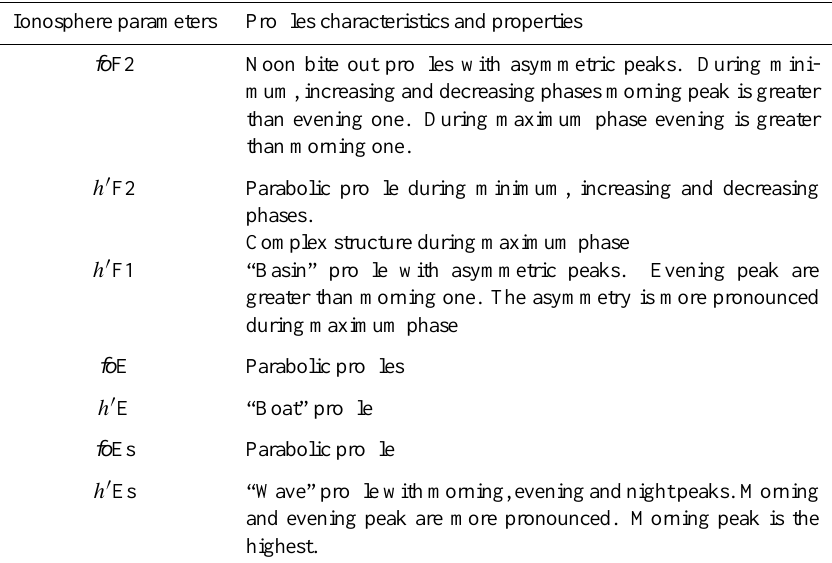
Table 2. Ionosphere diurnal profiles characteristics and properties. Ionosphere parameters Profiles characteristics and properties fo F2 Noon bite out profiles with asymmetric peaks. During mini- mum, increasing and decreasing phases morning peak is greater than evening one. During maximum phase evening is greater than morning one. h 0 F2 Parabolic profile during minimum, increasing and decreasing phases. Complex structure during maximum phase h 0 F1 “Basin” profile with asymmetric peaks. Evening peak are greater than morning one. The asymmetry is more pronounced during maximum phase fo E Parabolic profiles h 0 E “Boat” profile fo Es Parabolic profile h 0